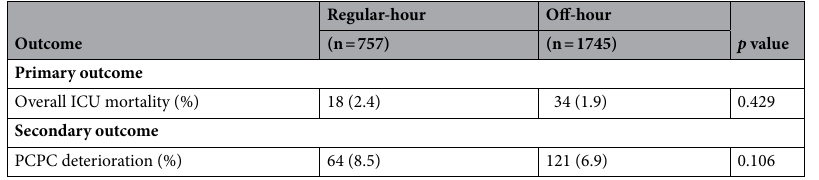
Table 2. Crude number and proportion of primary and secondary outcomes in each group. ICU intensive care unit, PCPC pediatric cerebral performance category. PCPC deterioration was defined as any deterioration in PCPC score at discharge compared with PCPC score before admission.